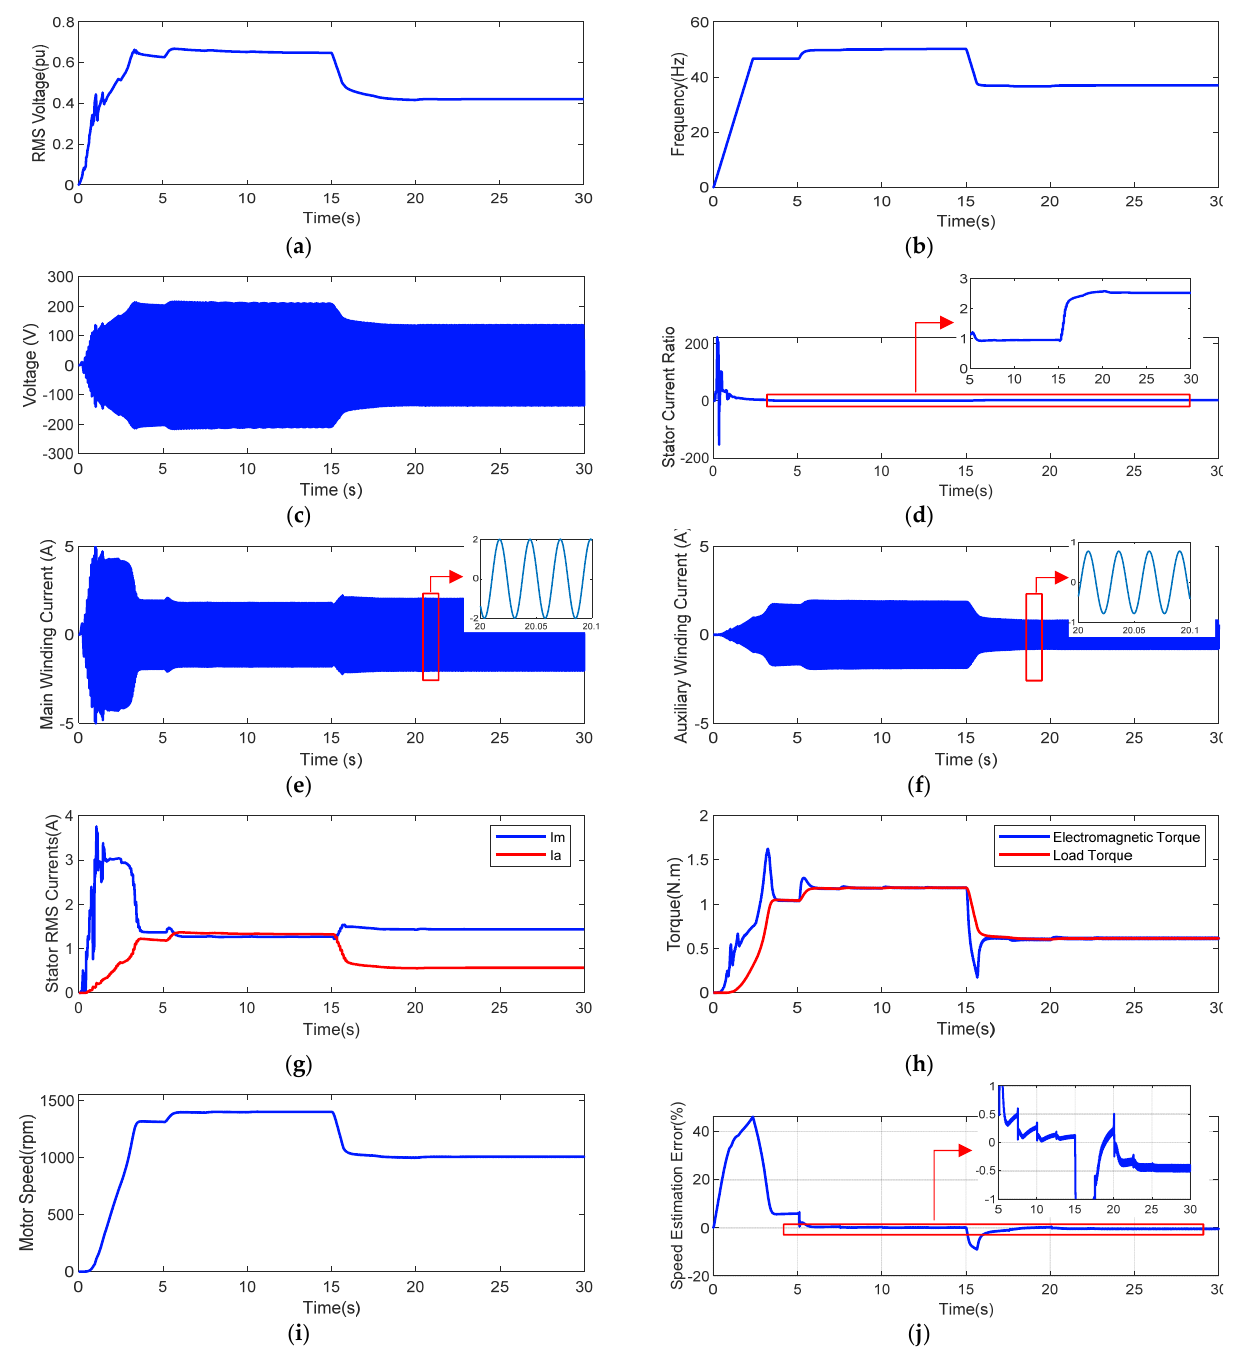
Figure 6. Simulation results with step change in speed set point. ( a ) rms voltage, ( b ) frequency, ( c ) voltage waveform, ( d ) stator current ratio, ( e – g ) stator main and auxiliary winding currents, ( h ) motor and load torque, ( i ) motor speed and ( j ) speed estimation error.